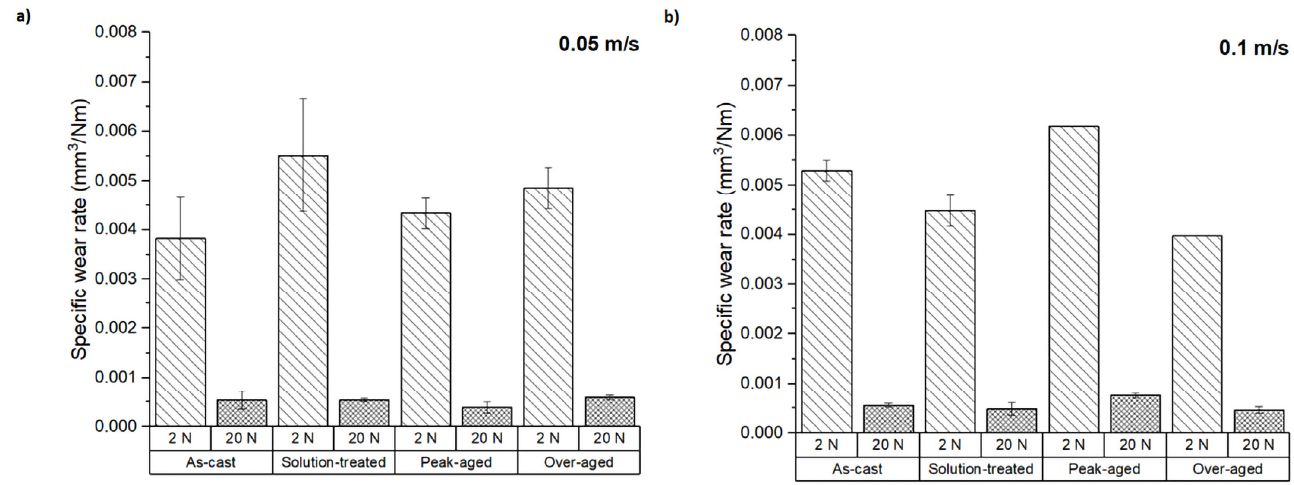
Figure 4. Specific wear rates at sliding speeds of ( a ) 0.05 m s − 1 and ( b ) 0.1 m s − 1